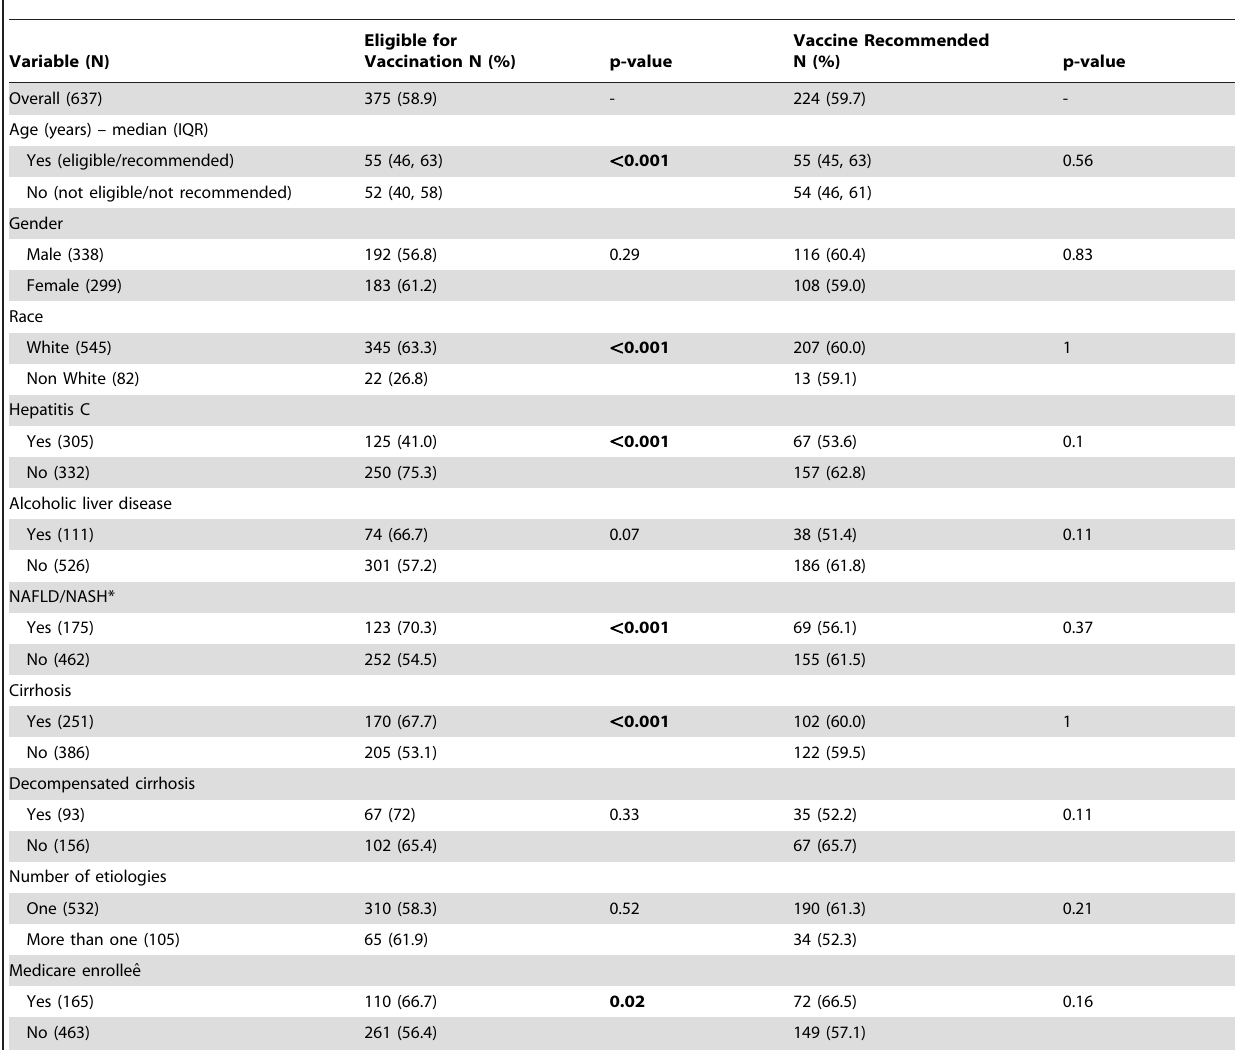
Table 4. Eligibility for Hepatitis B vaccination among 637 new chronic liver disease patients and the proportion where it was recommended at the liver